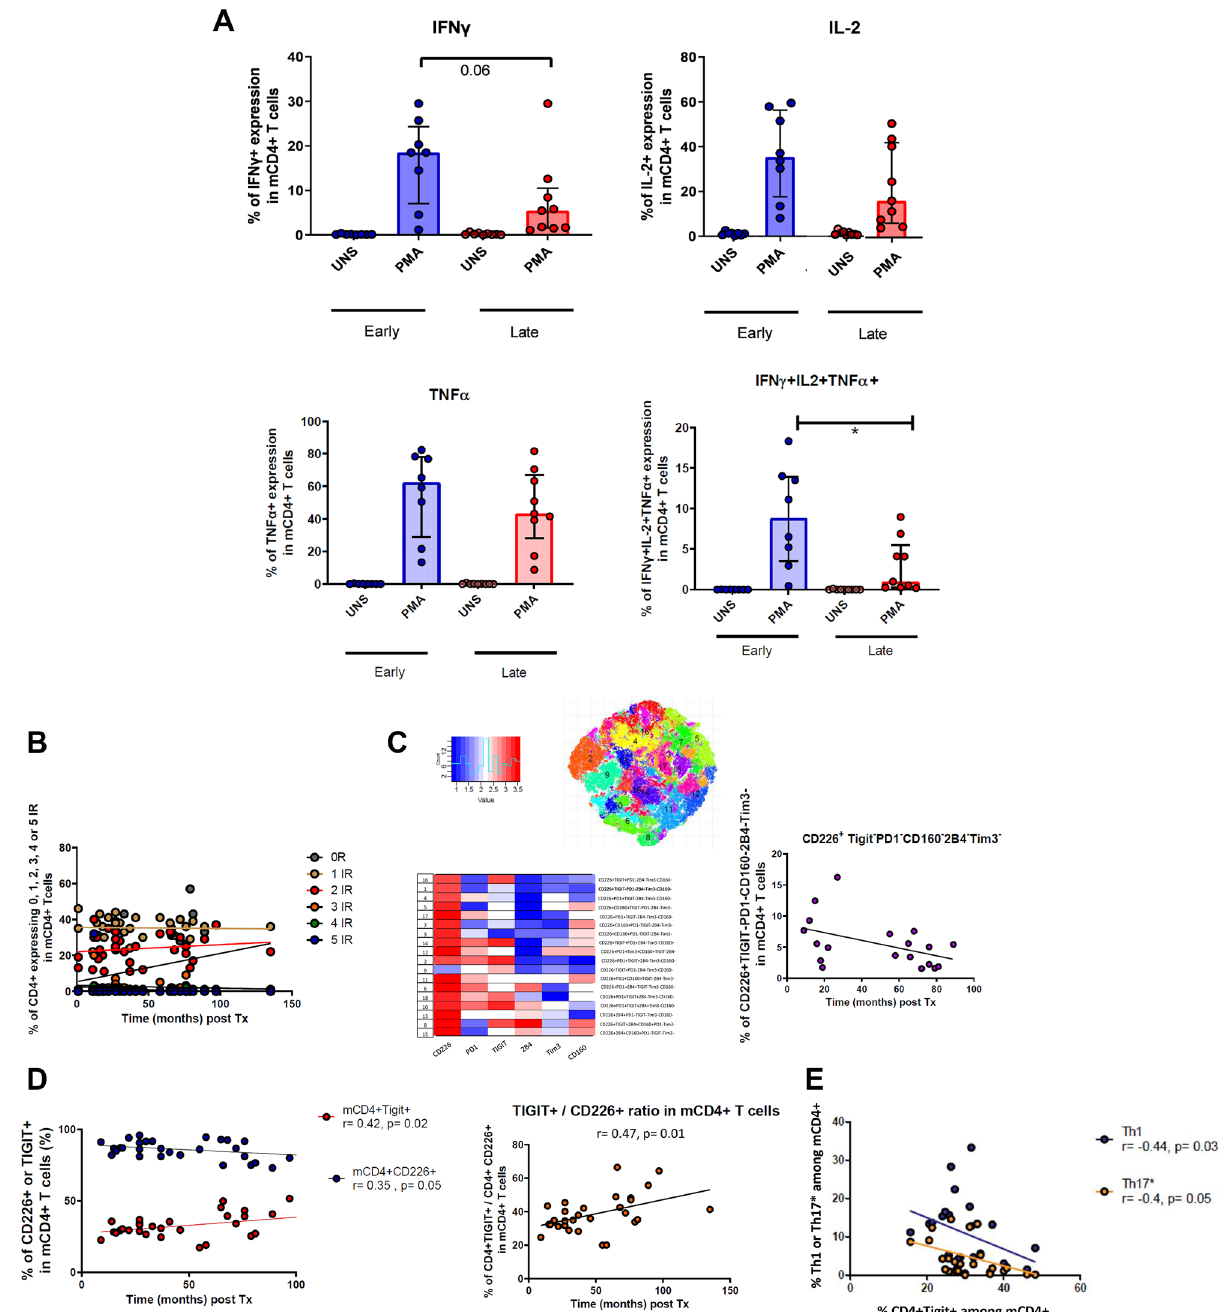
Figure 2. ( A–E ) Functional and phenotypic analyses of mCD4 + T cells. Comparisons were performed by an unpaired Mann–Whitney t-test. Statistical correlation was performed using a Spearman correlation test. ( A ) IFNγ, IL-2 and TNFα, and IFNγ + IL-2 + TNFα + production in mCD4 + T cells in unstimulated (UNS) or after PMA-ionomycin stimulation in early (< 3 months) and late (> 2 years) transplant patients. ( B ) Percentage of memory CD4 + T cells expressing 0, 1, 2, 3, 4, or 5 inhibitory receptors. ( C ) Unbiased clustering analysis of inhibitory receptor expression and CD226 expression in mCD4 + T cells after transplantation. ( D ) TIGIT, TIGIT + CD226 + expression in mCD4 + T cells (left) and TIGIT/CD226 expression ratio in memory CD4 + T cells. ( E ) Correlation between percentage of CXCR3 + CCR6- (Th1), and CXCR3 + CCR6 + (Th17*) subsets and percentage of TIGIT + CD4 + in memory CD4 + T